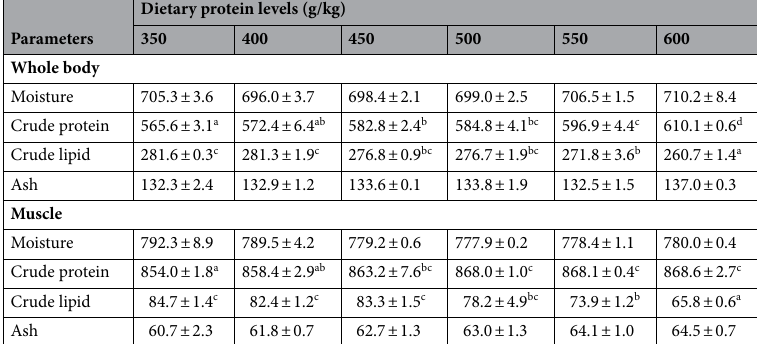
Table 3. Effect of dietary protein level on whole body and muscle composition of juvenile orange-spotted grouper (g/kg). Notes: Values in the table are means ± SD (n = 3). Values in the same line with different superscripts indicate significant difference ( P < 0.05).